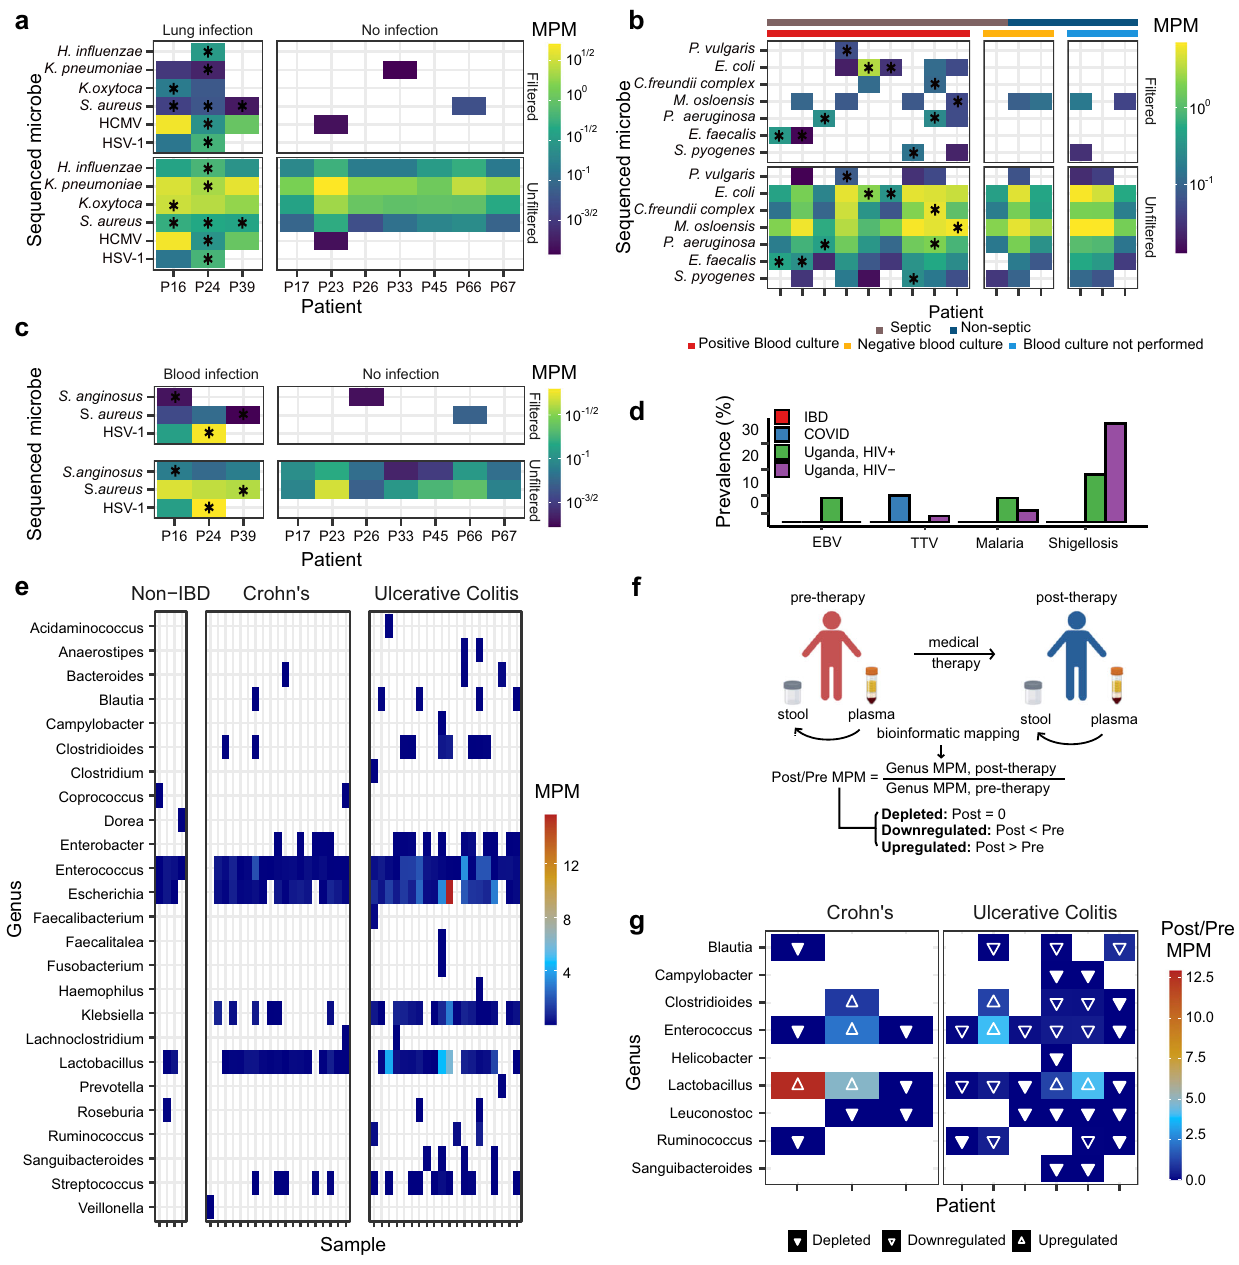
Fig. 4 Application of SIFT-seq to plasma. Heatmaps of the abundance of species identi fi ed in plasma from COVID-19 patients with and without culture con fi rmed ( a ) lung and ( b ) blood infection, before and after application of SIFT-seq fi lter (black * indicates agreement with culture; HCMV: Human cytomegalovirus, HSV-1: Herpes simplex virus 1). c A heatmap of abundance of species identi fi ed in the sepsis cohort before and after SIFT-seq fi ltering (black * indicates species identi fi ed by blood culture). d Barplot of the prevalence of Epstein-Barr Virus (EBV), Torque teno virus (TTV), malaria-causing, or shigellosis-causing microorganisms in different patient cohorts. e Heatmap of the abundance of species identi fi ed in matched stool and plasma cfDNA samples in patients diagnosed with Crohn ’ s disease or ulcerative colitis. f Schematic for matched stool and plasma samples from individuals before and after medical therapy. g Heatmap of the change in abundance of gut-speci fi c bacteria before and after treatment. Source data are provided as a source data fi le. infection 24 . According to the World Health Organization, in 2017 results when performed directly on blood, the low microbial bur- there were 48.9 million sepsis cases and 11 million sepsis-related den in blood leads to low sensitivity, low negative predictive values, deaths worldwide. When sepsis is suspected, broad-spectrum and detection of only a few speci fi c pathogens 25 . Thus, conven- empiric antibiotics are administered, and tests are performed to tional metagenomic cfDNA sequencing holds promise in identi- identify the infection-causing pathogens. Blood culture is the gold fying sepsis-causing pathogens 26,27 . standard method to detect infectious pathogens in the bloodstream, We tested the utility of SIFT-seq to identify sepsis-causing however this method is time consuming and limited to few cul- pathogens in patients with sepsis. For this, we performed a blinded turable microbes. Though other molecular tests can shorten time to analysis on 15 plasma samples ( n = 10 from septic patients and NATURE COMMUNICATIONS| (2022) 13:4197